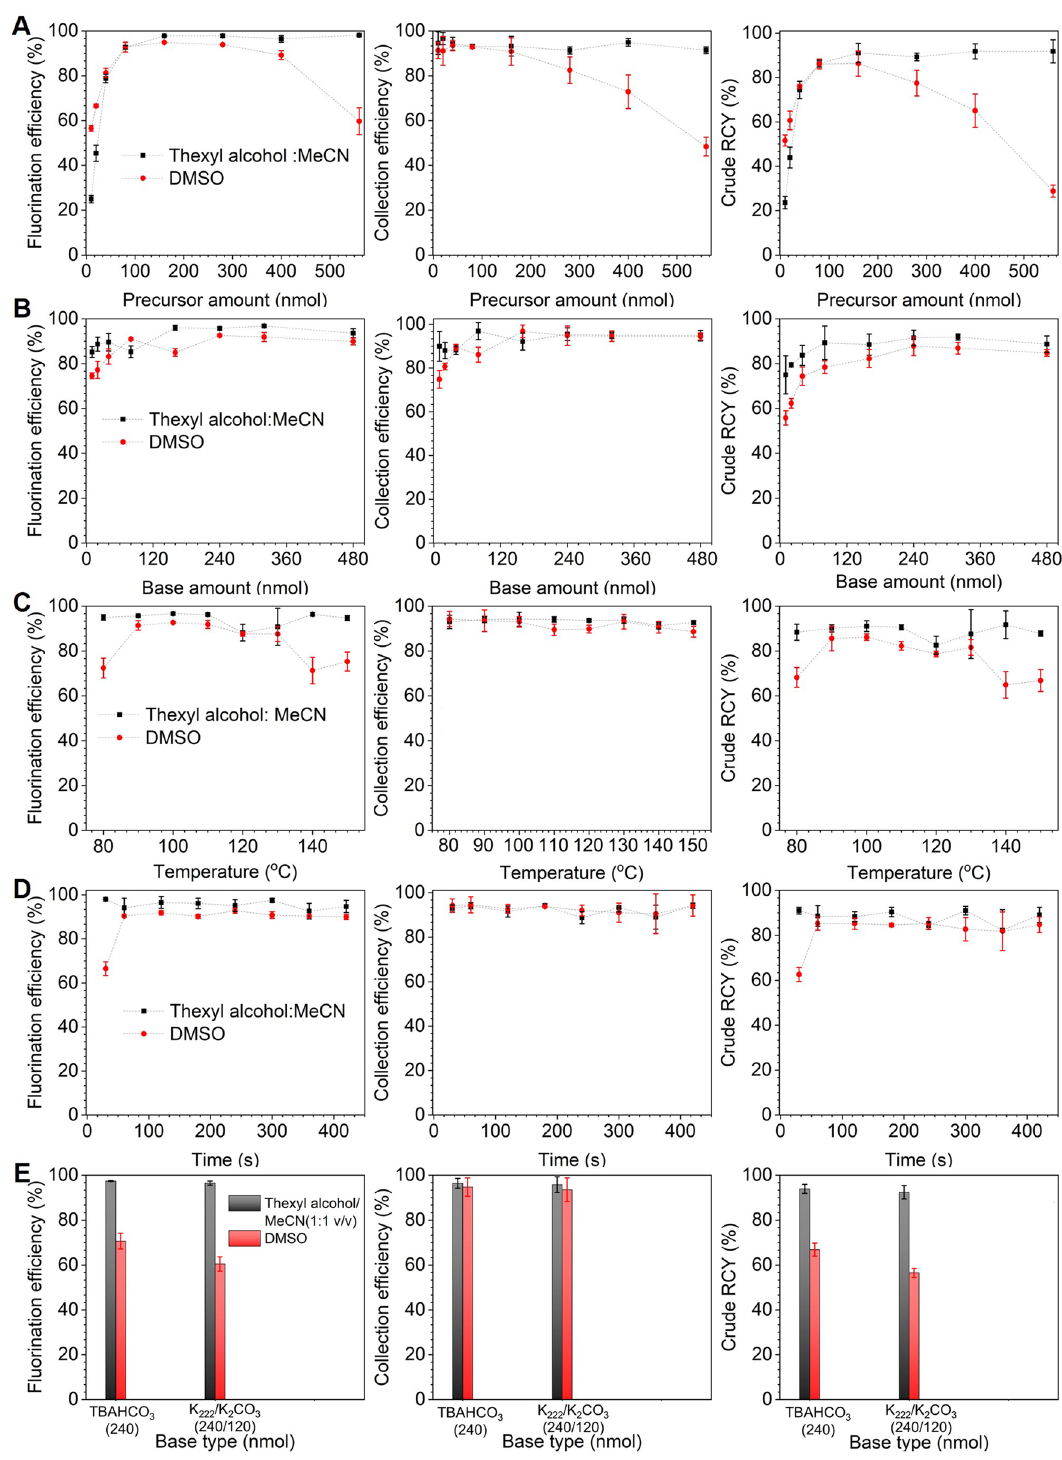
Figure 5. Influence of reaction parameters on the performance of the microdroplet radiosynthesis of [ 18 F] PBR06. For each parameter, influence on fluorination efficiency, collection efficiency, and crude RCY are plotted individually. ( A ) Effect of precursor concentration (and solvent). Reaction volume: 8 µL. Base amount: 240 nmol. Reaction time: 5 min. Reaction temperature 100 °C. ( B ) Effect of amount of base (and solvent). Precursor amount: 160 nmol. Reaction volume: 8 µL. Reaction temperature: 100 °C. Reaction time: 5 min. ( C ) Effect of temperature (and solvent). Precursor amount: 160 nmol. Reaction volume: 8 µL. Base amount: 240 nmol. Reaction time: 5 min. ( D ) Effect of reaction time (and solvent). Precursor amount: 160 nmol. Reaction volume: 8 µL. Base amount: 240 nmol. Reaction temperature: 100 °C. ( E ) Effect of the base type. Precursor amount: 160 nmol. Reaction volume: 8 µL. Base amount: 240 nmol. Reaction temperature: 100 °C. Reaction time: 0.5